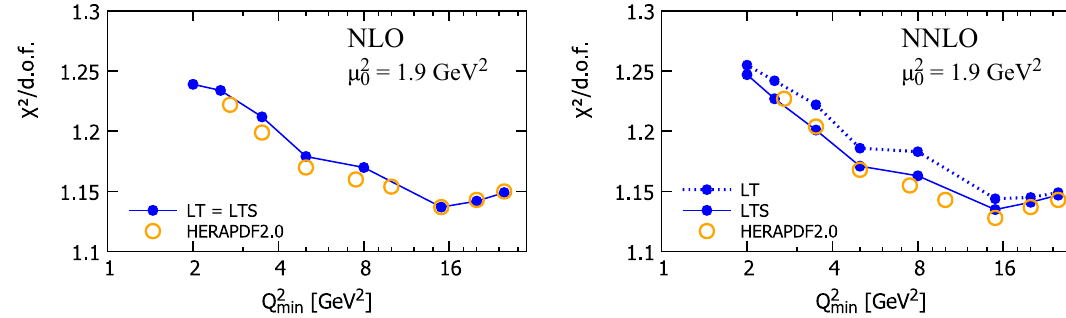
= 1 . 9GeV 2 fits to the data with the Q 2 ≥ Q 2 0